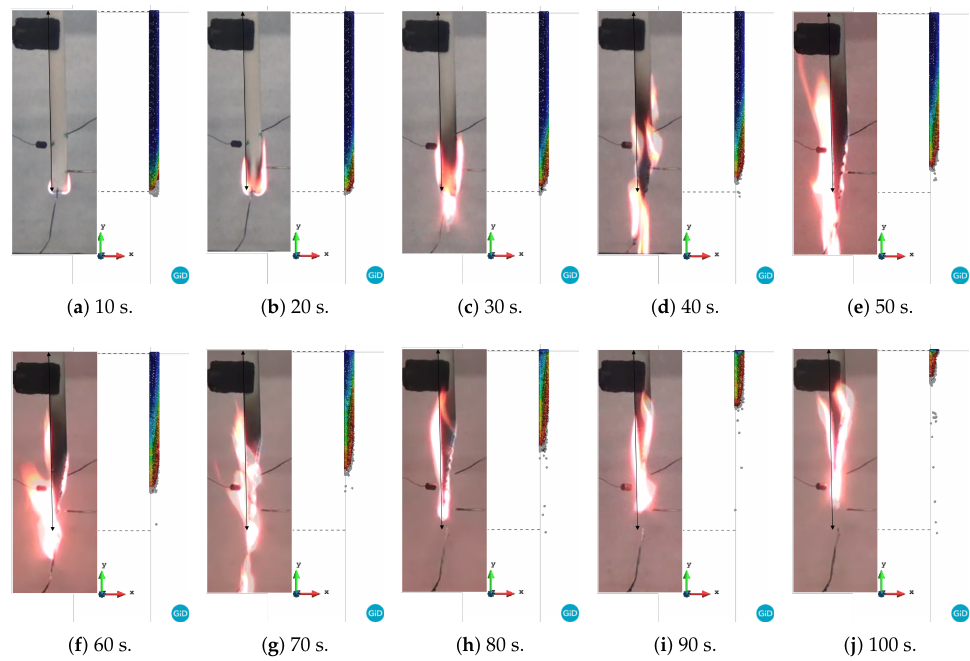
Figure 8. Comparison between experimental versus PFEM results for curve 1: blue and red corre- spond to 298 and 1000 K,